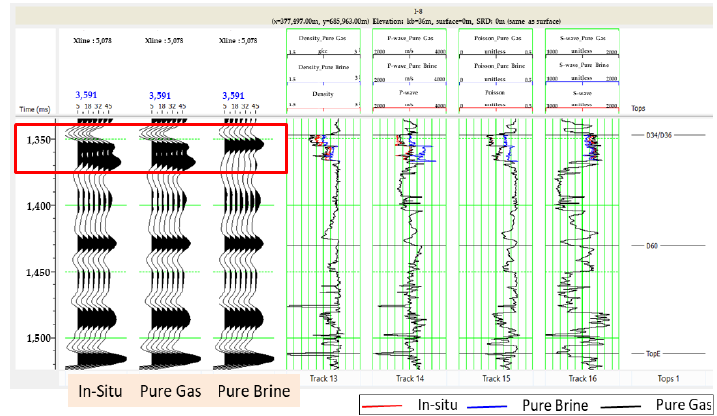
Figure 10. Gassman fluid substitution in one of the reservoir intervals (Top D34/36) from Well I-8. Figure 10. Gassmann’s fluid substitution in one of the reservoir intervals (Top D34 / 36) from Well I-8. The red rectangle was the interval of hydrocarbon. The red rectangle was the interval of hydrocarbon.